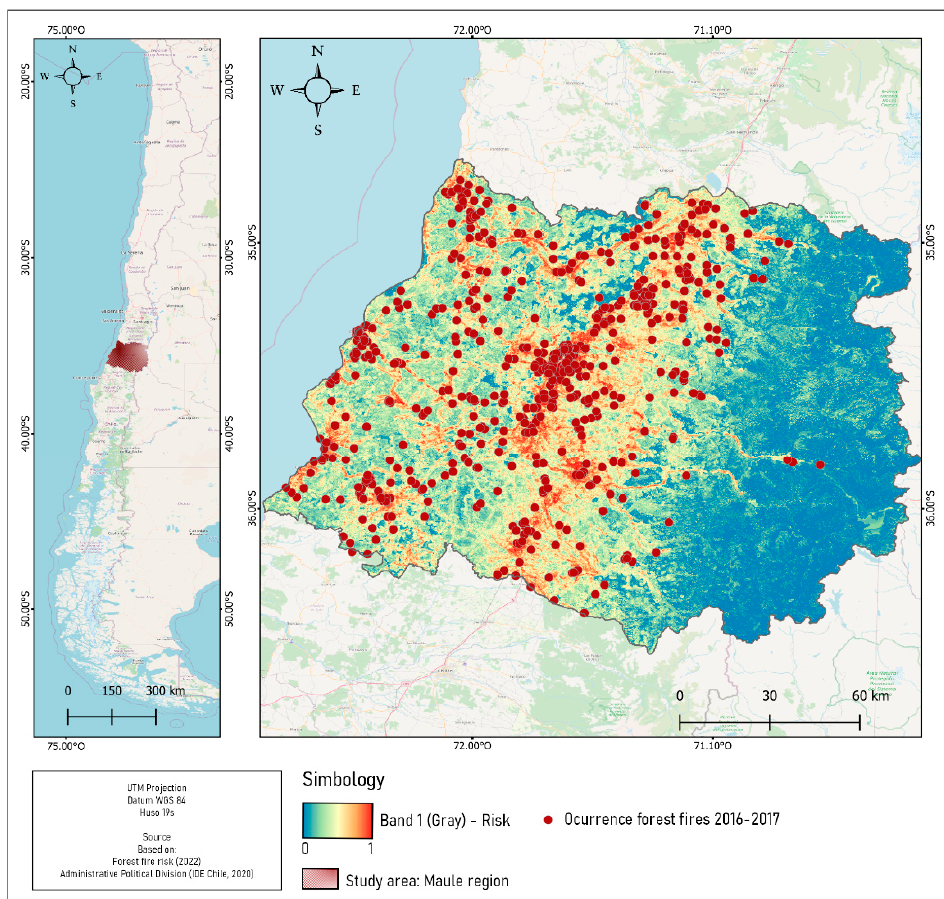
Figure 7. Ignition risk map and ignition points during 2016–2017 season.